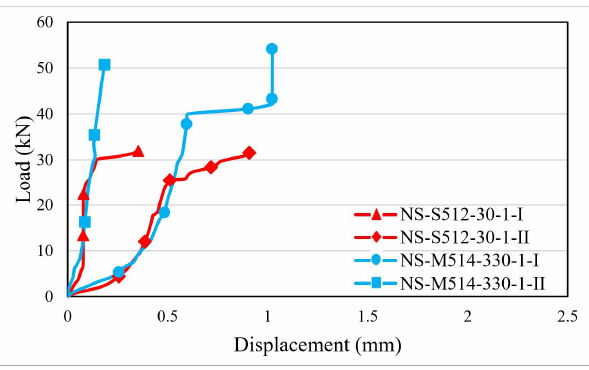
Figure 9. Load–displacement curves for specimens made with non-sandblasted steel plates.